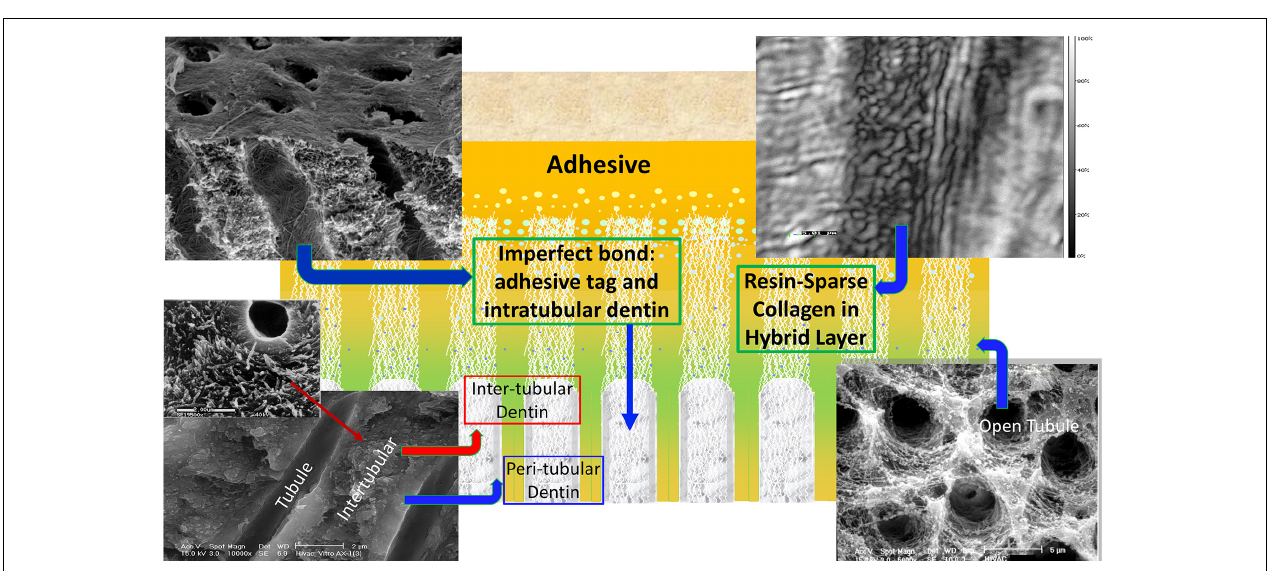
FIGURE 1 | Exfoliated primary molar with Class II composite restoration. Brown stain along the interface between the composite material and tooth structure indicates recurrent decay at the material/tooth interface.